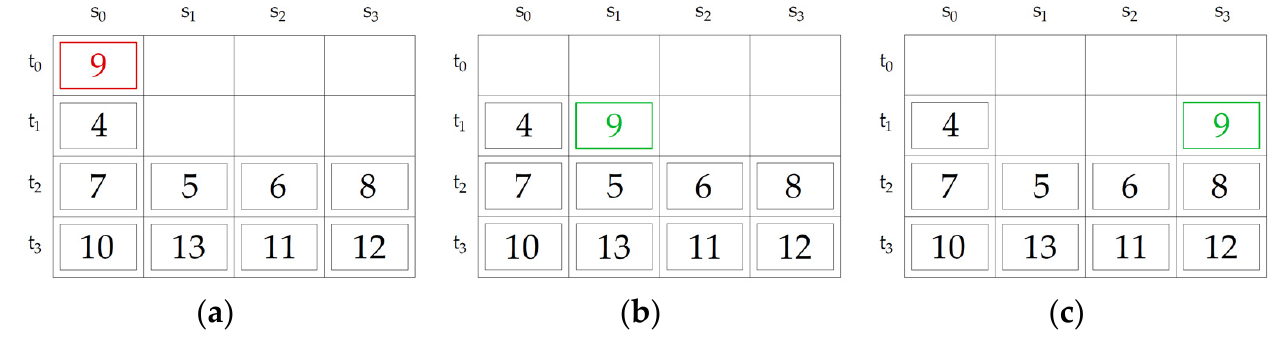
Figure 13. An example of a different solution of container relocation between our previous method and the proposed method: ( a ) Current situation within the yard bay; ( b ) the situation within the yard bay after applying one possible rule proposed in [17]; and ( c ) the situation within the yard bay after applying one relocation of our newly proposed method.